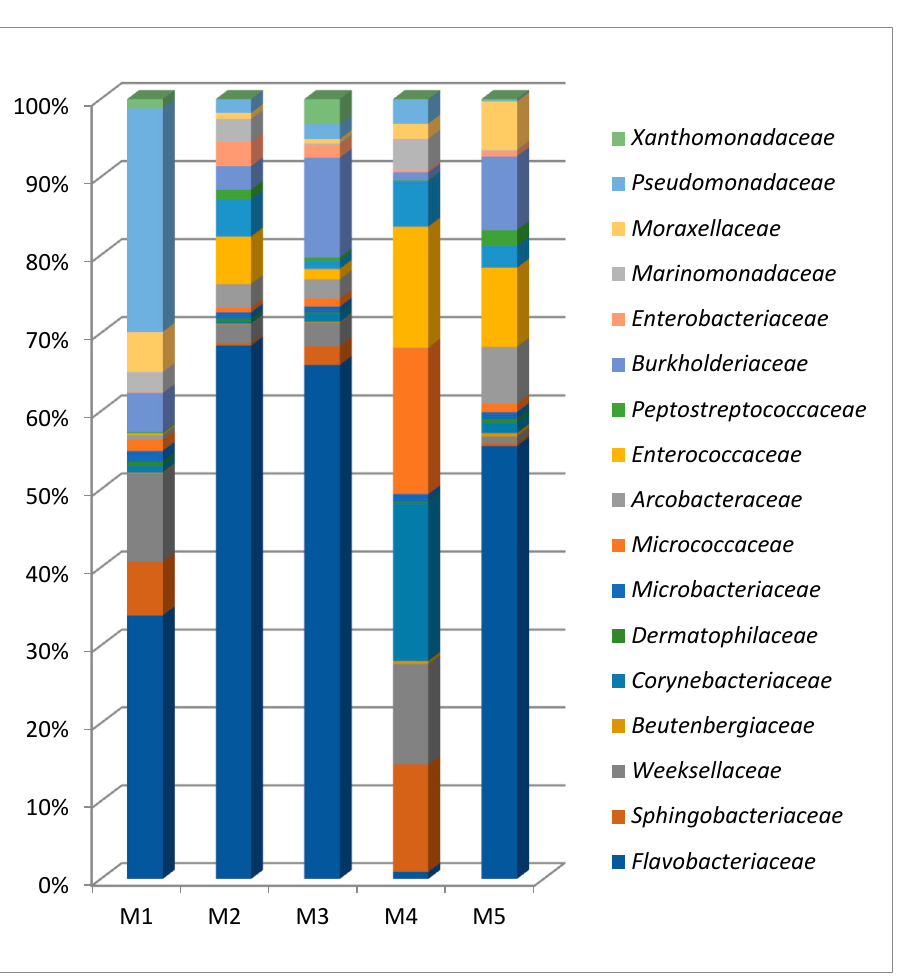
Figure 8. The general of the families found in each samples according to relative abundance. M1, M2, M3, M4 and M5 represent each food processing specific location (x–axis). Color boxes represent bacterial abundance (y–axis).